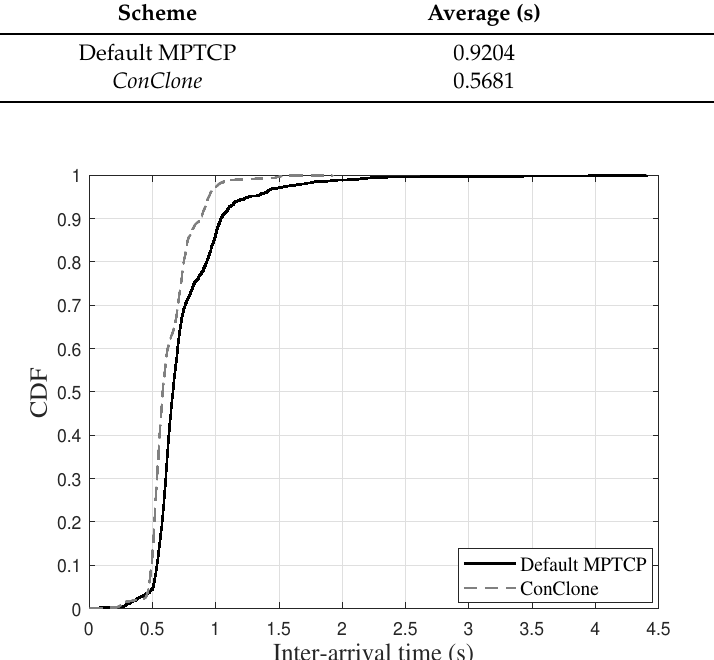
Figure 11. Cumulative distribution function (CDF) of inter-arrival time in long-term